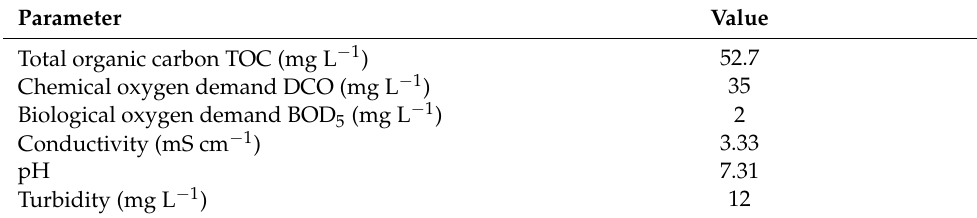
Table 3. Physicochemical properties of the collected